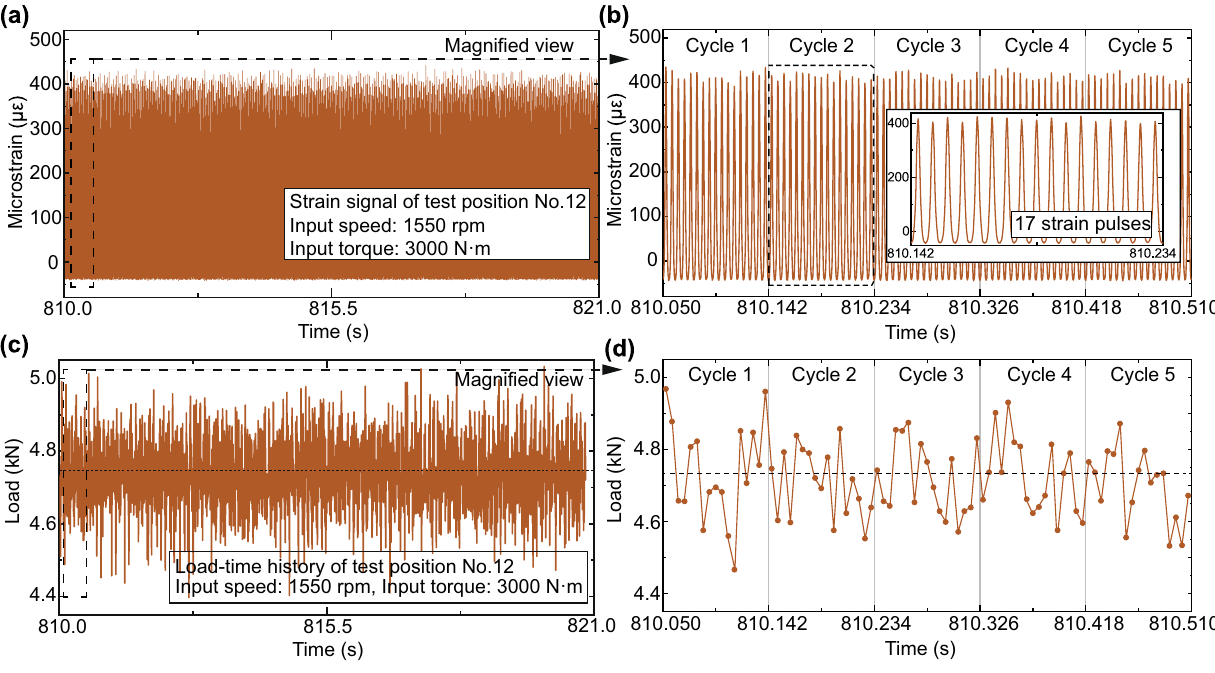
Fig. 7 Typical measured strain signal and contact load time history obtained accordingly of the test position No.12 under conditions of input speed 1550 rpm and input torque 3000 N·m: a measured strain signal; b magnified view of the strain signal; c measured real-time distributed contact load; d a magnified view of the contact load time